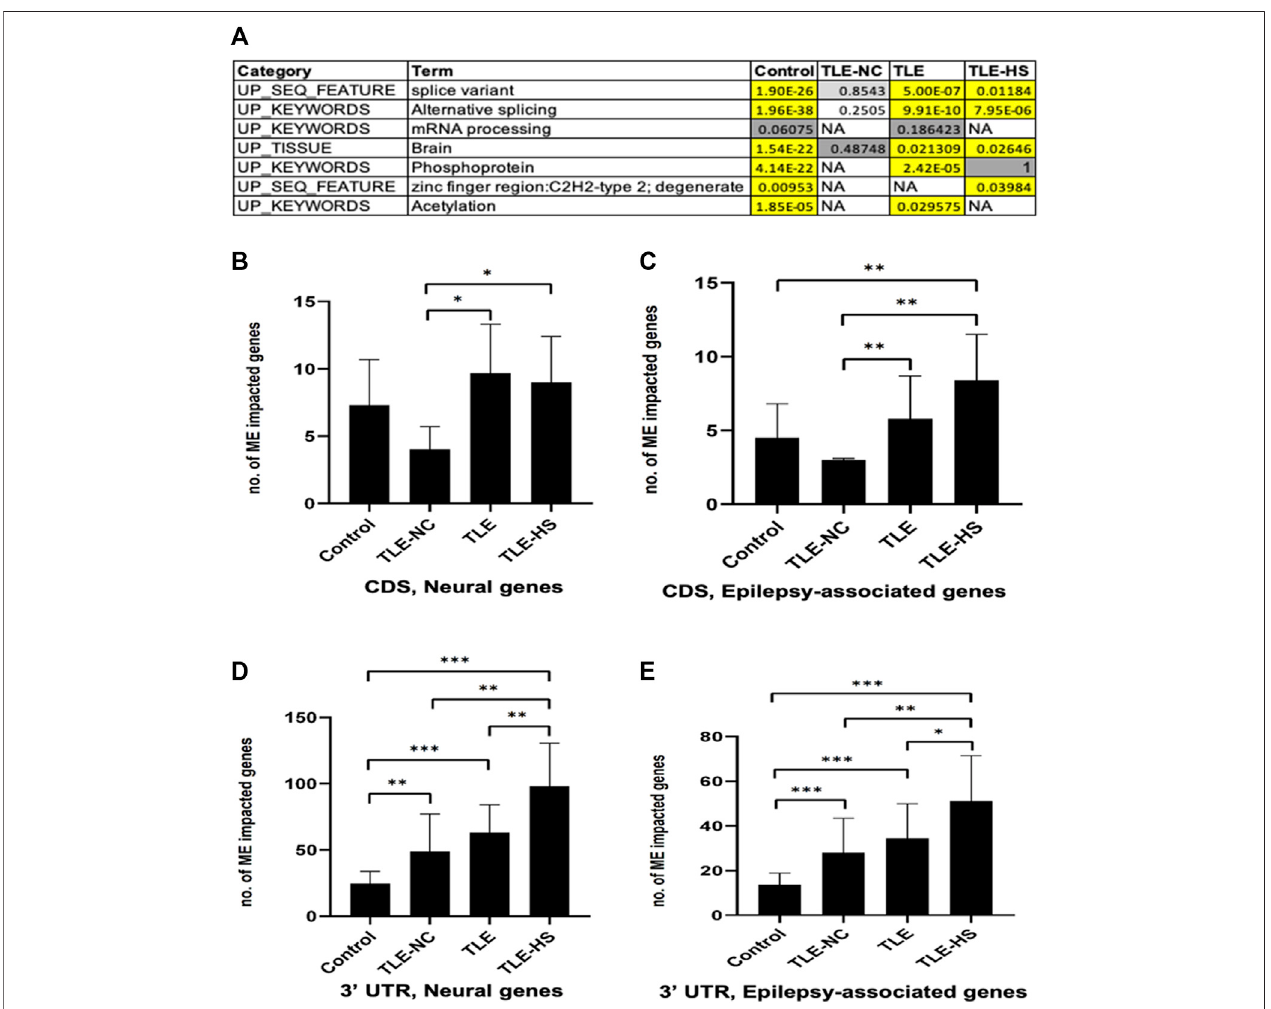
FIGURE 2 | Frequency of mobile elements (MEs) in the transcripts of neural and epilepsy-associated genes and function categories enriched by genes associated withME-transcripts. (A) FunctioncategoriesenrichedbygenesassociatedwithME-transcriptsinhumangroups.Cellsintheredbackgroundindicatethatenrichmentis statistically signi fi cant with the raw p -value and Benjamini adjusted p -value below 0.05; cells in the gray background indicate enrichment without statistical signi fi cance; NA: no enrichment for the category. B – E: Bar plots showing the average number of neural genes (B) and epilepsy-associated genes (C) in CDS regions and in 3 ′ UTR regions (D and E) . The statistical signi fi cance ofthe differencesbetween twosamplegroups isindicatedby thebracket lines at the top ofthe bar plots with p -value < 0.001 indicated by “ *** “ , p -value < 0.01 indicated by “ ** “ , and p -value < 0.05 indicated by “ * “ .